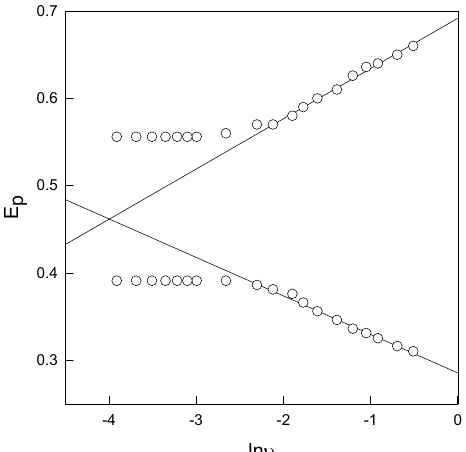
) and the natural logarithm of Figure 4 . Relationship between the peak potential ( E p scan rate (ln ν ) for CuCoHCF-modified electrode in 0.5 M KCl solution and the linear fitting at scan rates from 170 mV/s to 600